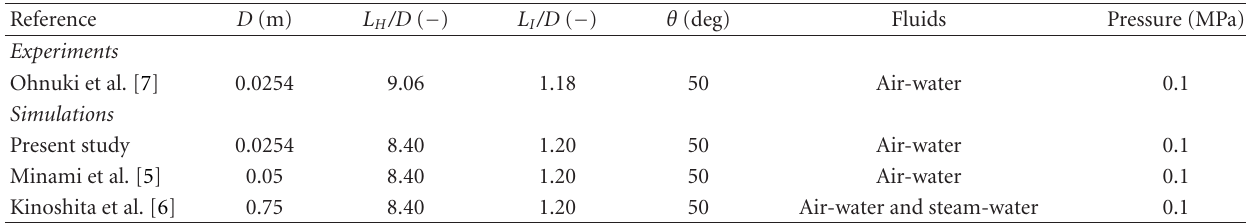
Table 2: Test section dimensions and experimental and simulation